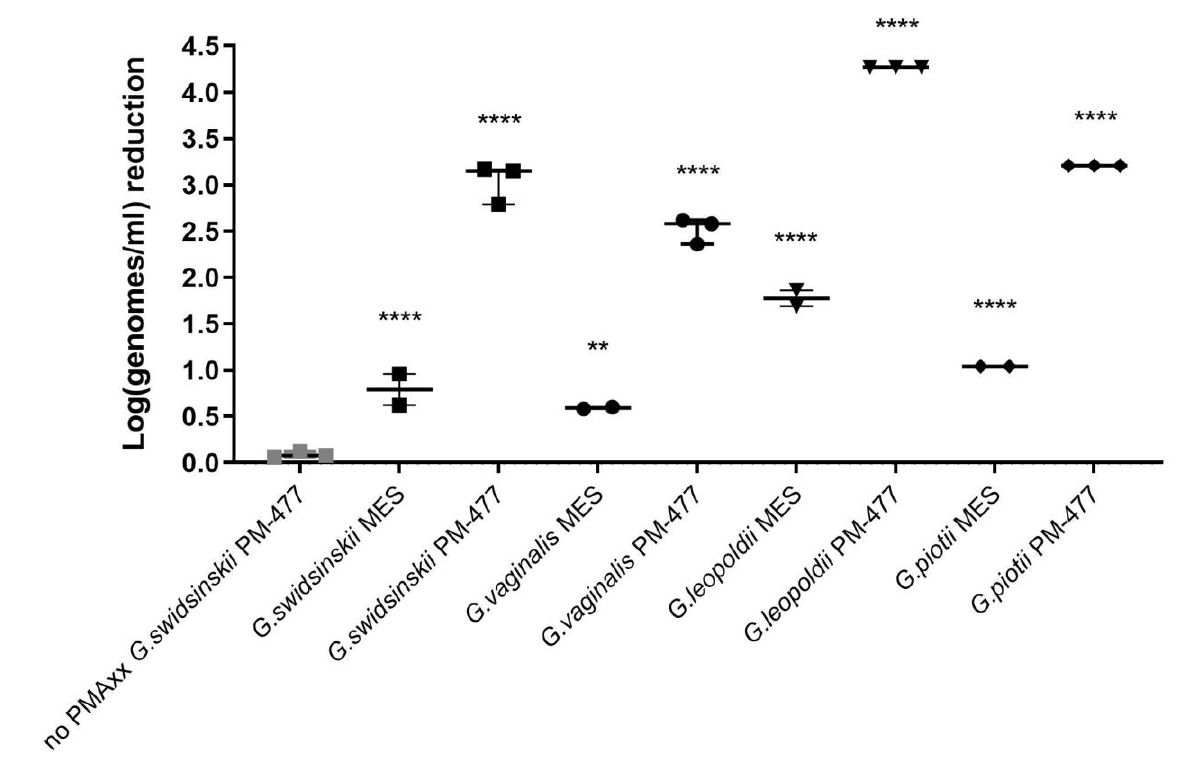
Figure 2. Reduction of cells (log(genomes/mL)), killed by 0.05 mg/mL PM-477 during overnight anaerobic incubation at 37 °C in 75% humidity, as assessed by optimized PMAxx treatment conditions (15 min on ice incubation with 0.05 mM PMAxx, followed by 15 min light exposure, repeated three times), DNA extraction and species-specific qPCR. Values are calculated as: log(number of MES-treated PMAxx-treated genomes/number of PM-477-killed PMAxx-treated genomes) and reduction of cells (log(genomes/mL)), not treated with PM-477, i.e., reduction due to PMAxx treatment itself. Values are calculated as: log(number of MES-treated PMAxx-non-treated genomes/number of MES-treated PMAxx-treated genomes). Legend: triangle: G. leopoldii , rhombus: G. piotii , square: G. swidsinskii , circle: G. vaginalis, grey symbols correspond to samples not treated with PMAxx, black symbols correspond to samples treated with PMAxx.; **: p -value < 0.01;; ****: p -value < 0.0001, as assessed by one-way ANOVA followed by Tukey’s multiple comparisons test in GraphPad